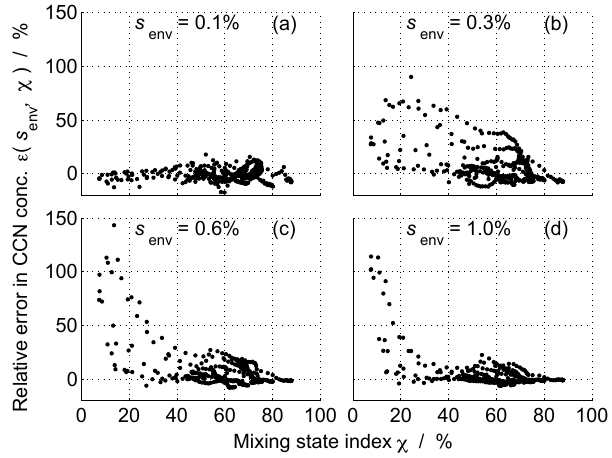
Figure 7. Relative error in CCN concentration (cid:15)(s env ,χ) for differ- ent environmental supersaturations; see Eq. (2) for